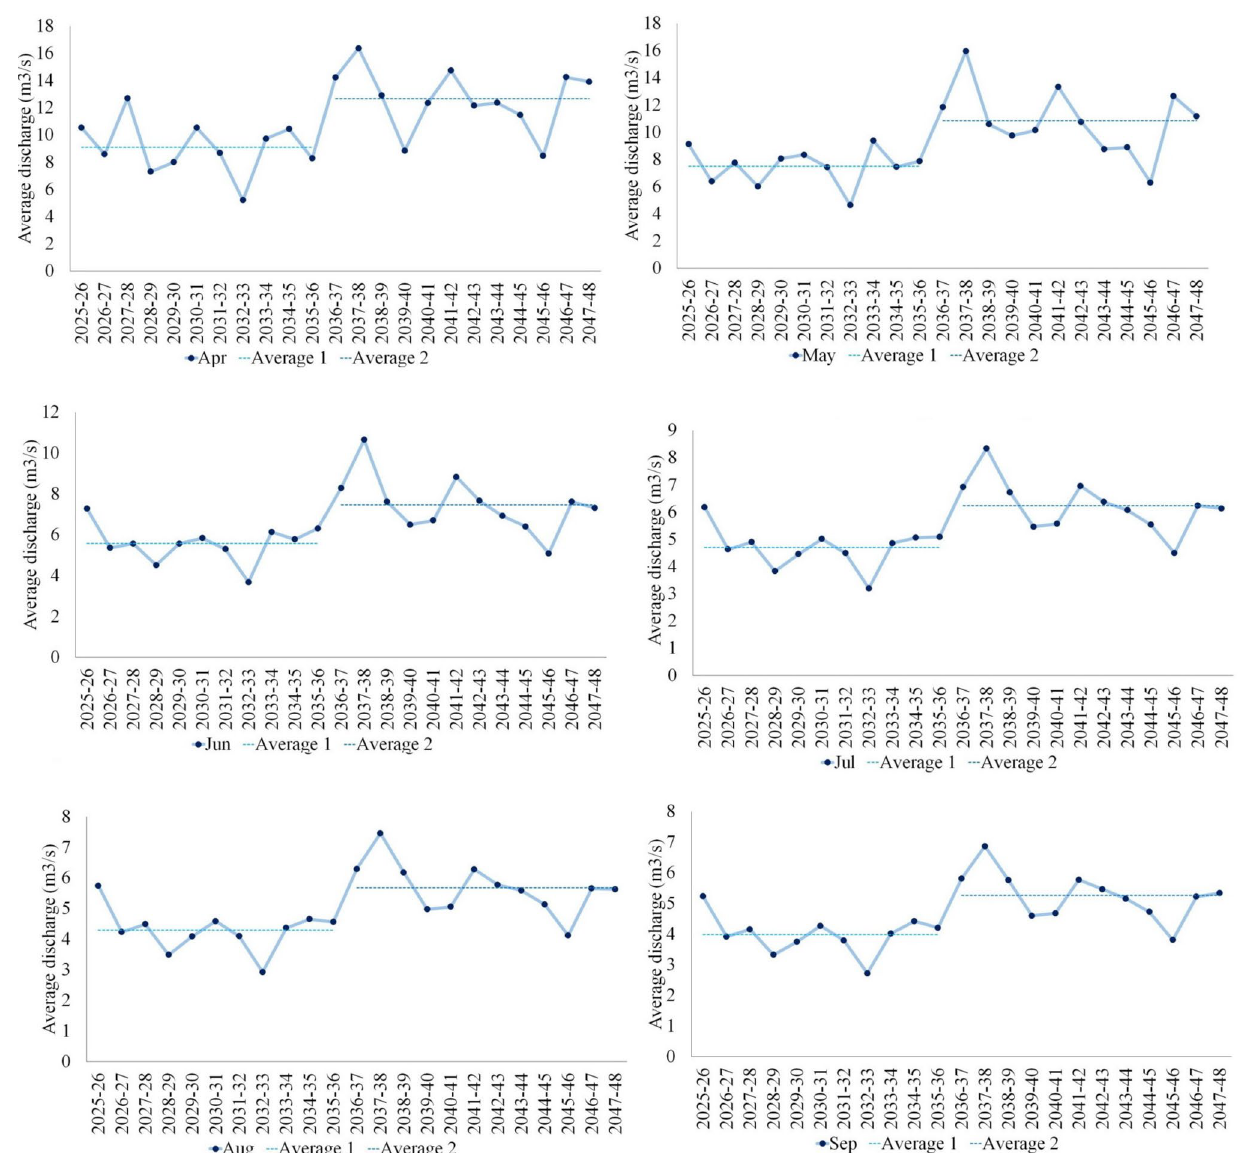
Fig. 12 Homogeneity test for the long-term mean streamflow in the future period under the scenario RCP8.5